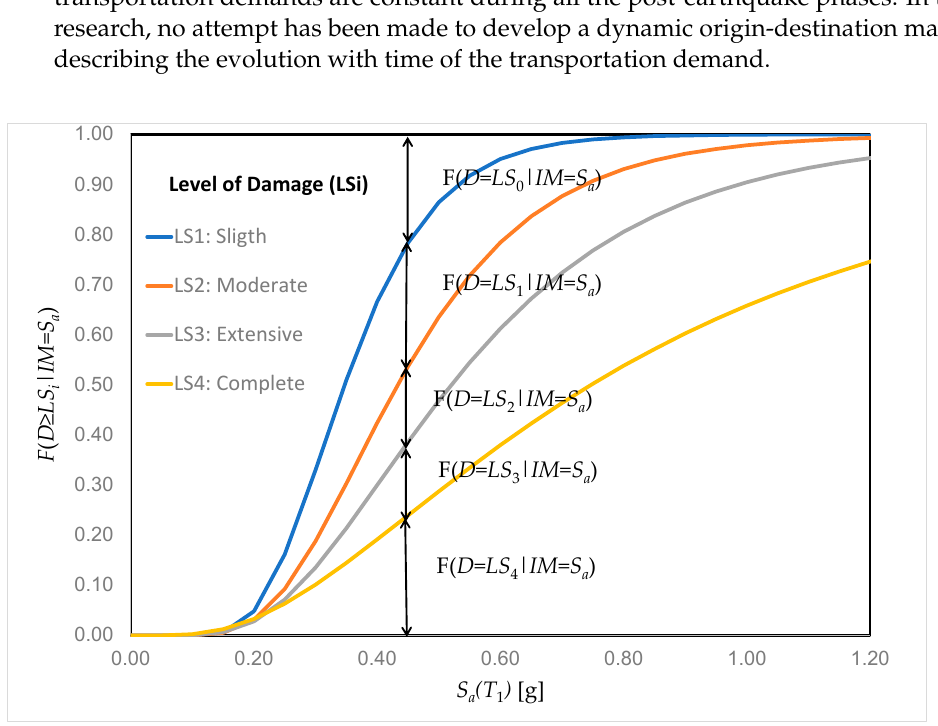
Figure 3. Set of fragility curved used in the present study.